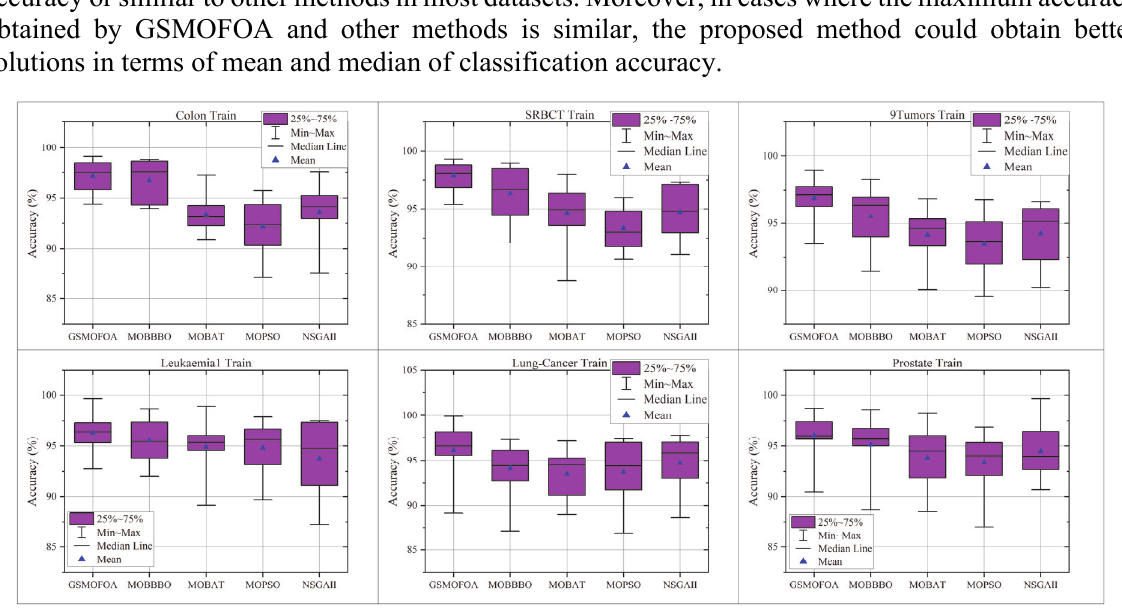
Fig. 8. Comparison of the accuracy of GSMOFOA solutions with those provided by other multi- objective algorithms on the train